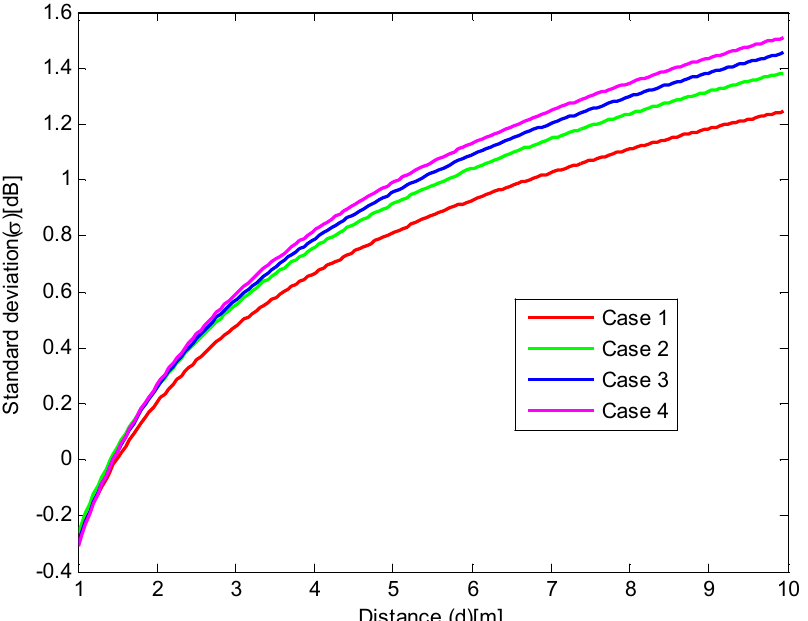
Figure 8. Comparison of relationship between the noise standard deviation and distance based on simulated data for four cases.